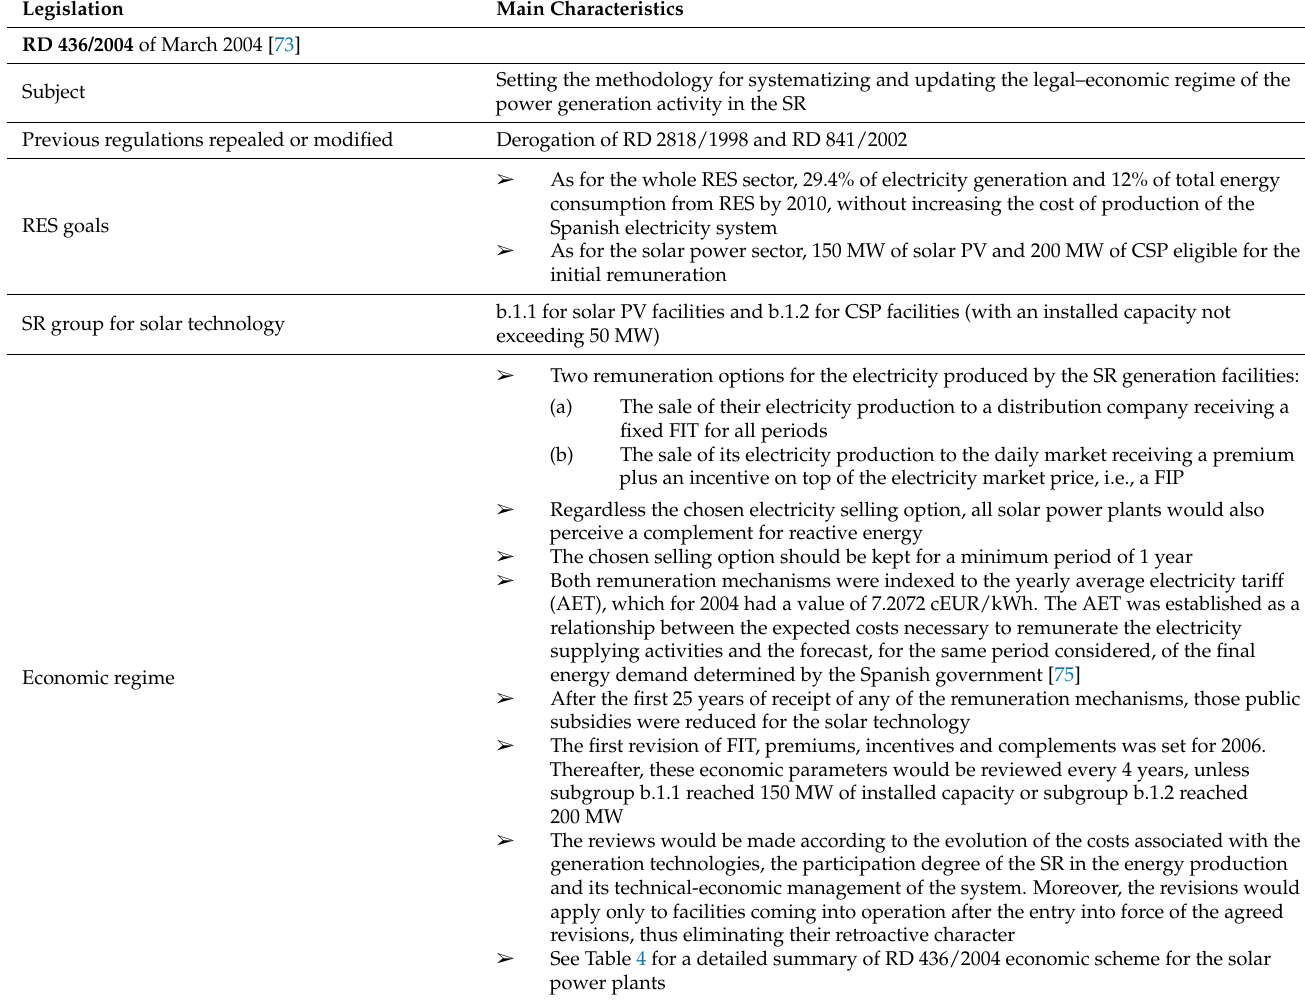
Table 3. Major characteristics of the different regulatory frameworks in force for solar power systems in Spain in the period 2004–2008. Source: self-elaboration based on